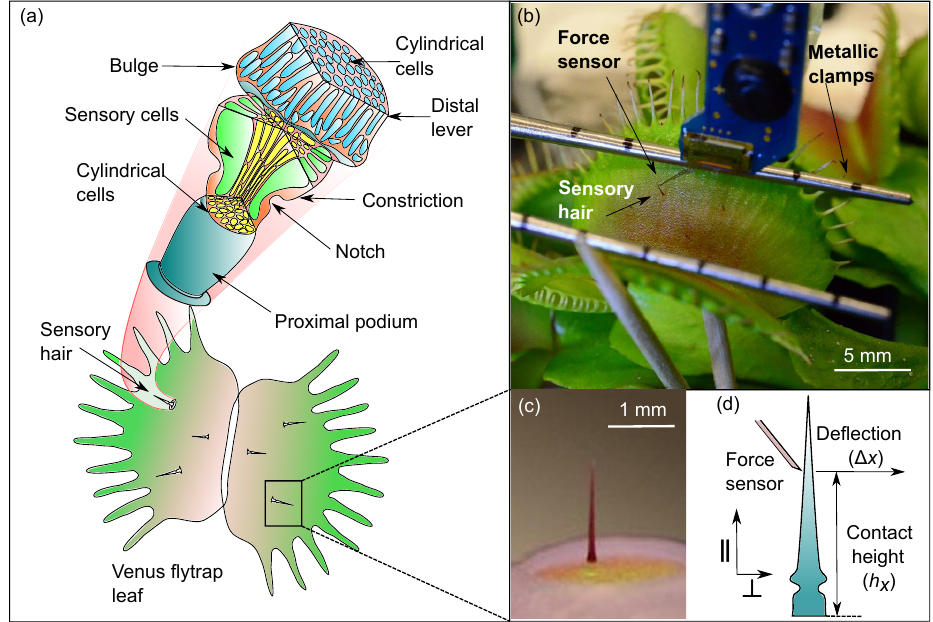
Figure 1. ( a ) Anatomical diagram of the sensory hair showing the various tissues (podium, con- striction, lever) and cells (sensory, cylindrical). ( b ) Experimental set up of the hair deflection tests comprising of a MEMS-based force sensor to impart stimuli and metallic clamps to constrain lobe movement. ( c ) A sensory hair taken from the flytrap lobe prepared for µ -CT imaging. ( d ) Force sensor contacting the hair at a height h x from the upper lobe epidermis, deflecting it horizontally by ∆ x